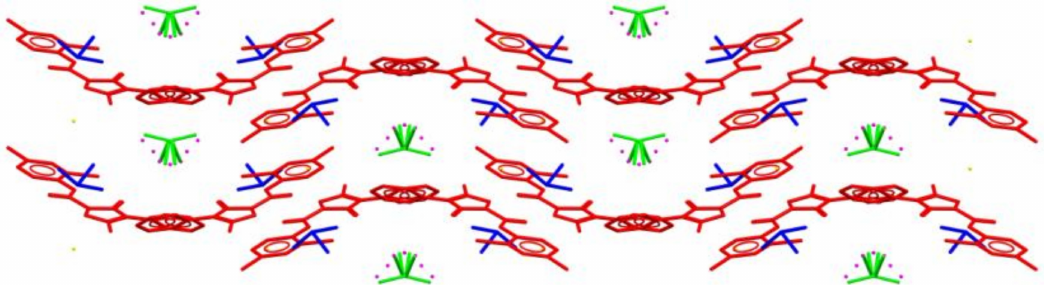
Figure 3. The crystal packing of 2 , viewed along the c